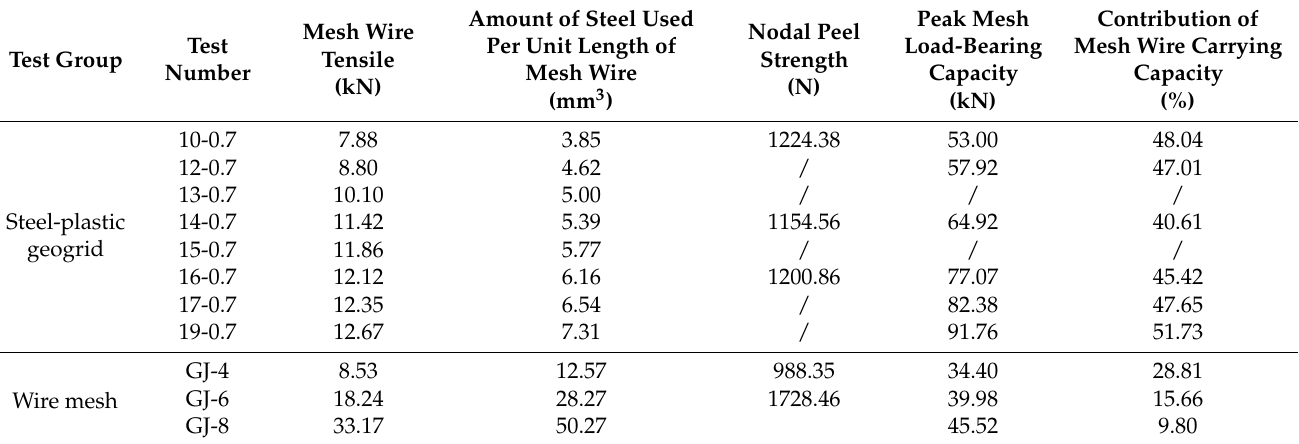
Table 4. Summary of indoor test